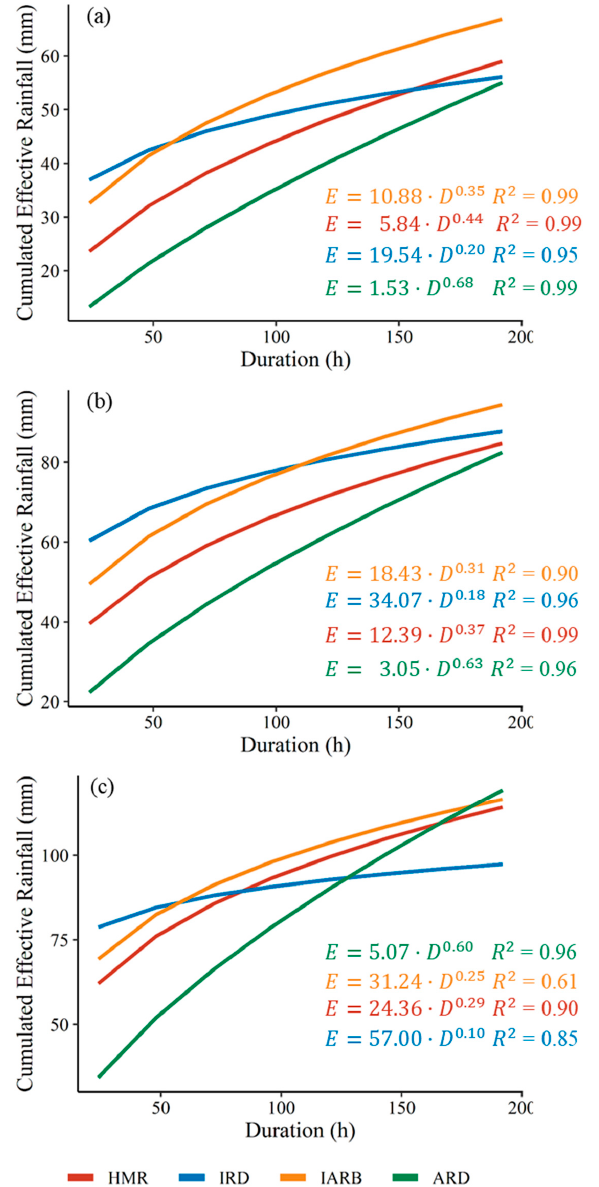
Figure 8. Rainfall thresholds for debris flow initiation for ( a ) low warning level, ( b ) medium warning level, and ( c ) high warning level of different rainfall patterns.